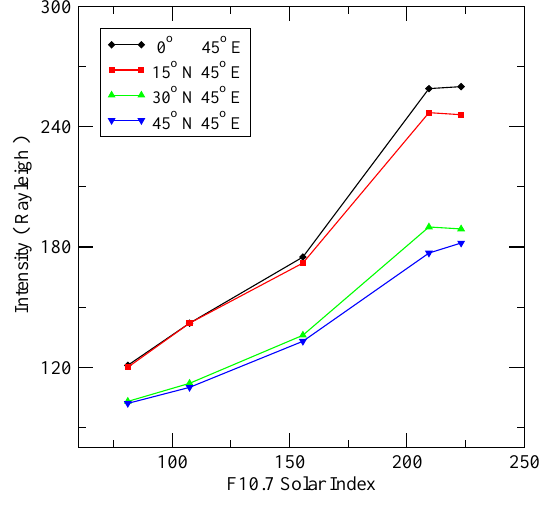
Fig. 3. Integrated column intensity variation with the solar activity at different locations in the Northern